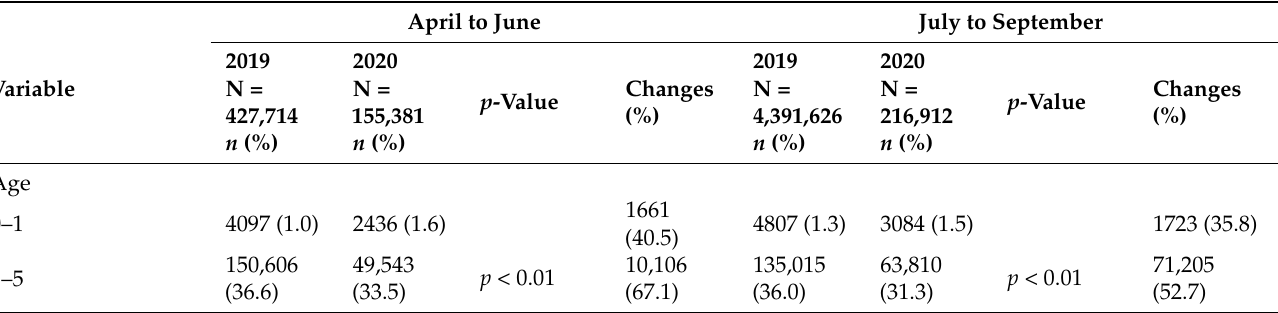
Table 1. Changes in Treat-and-Release Emergency Department Visits during COVID-19 pandemic by the patient and hospital